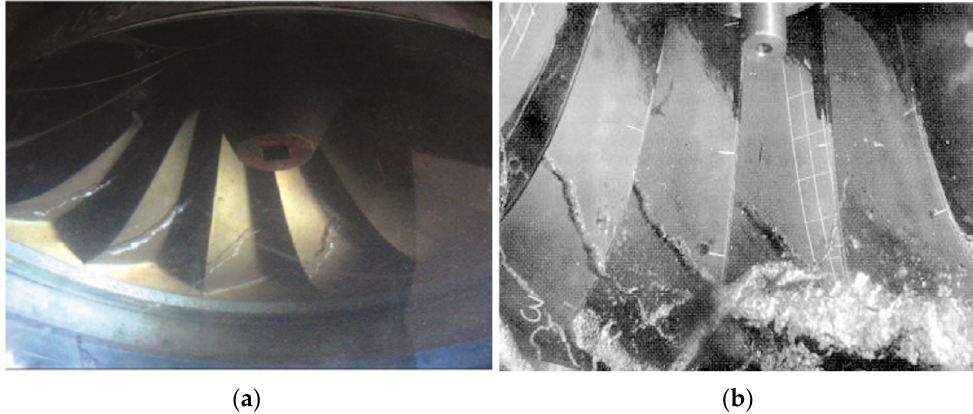
Figure 9. Channel vortex observed in experiment [17,27]. Note: ( a , b ) are the channel vortexes ob- served in the experiment.